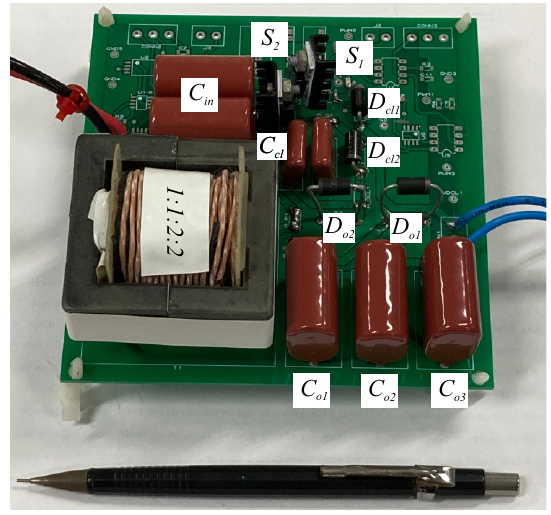
Figure 5. The assembled 400 W laboratory prototype. Table 2. Operational parameters and components used on the